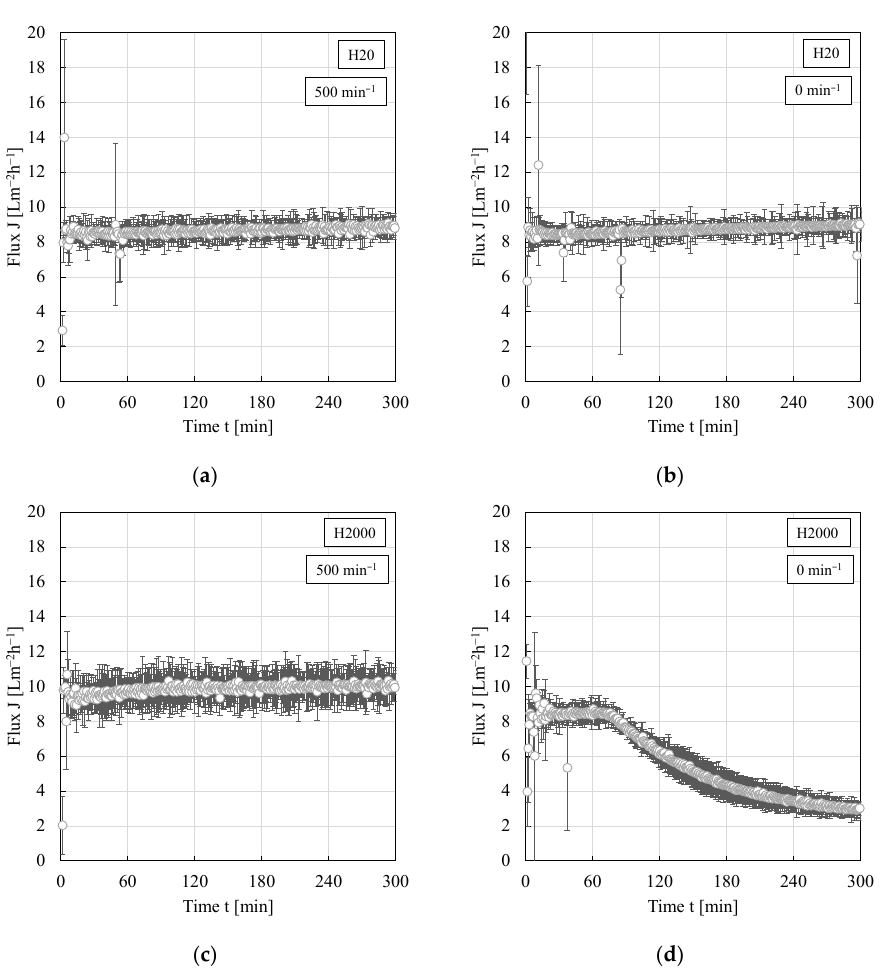
Figure 6. Flux as a function of time for w/o PEs stabilized by 0.5 wt.% of particle type ( a , b ) H20 or ( c , d ) H2000. Filtration experiments were conducted at a constant pressure of 4 bar and a constant dispersed phase fraction of 0.25 within the filtration cell. Experiments were conducted at least in duplicate and mean values are shown. Error bars represent the standard deviation.